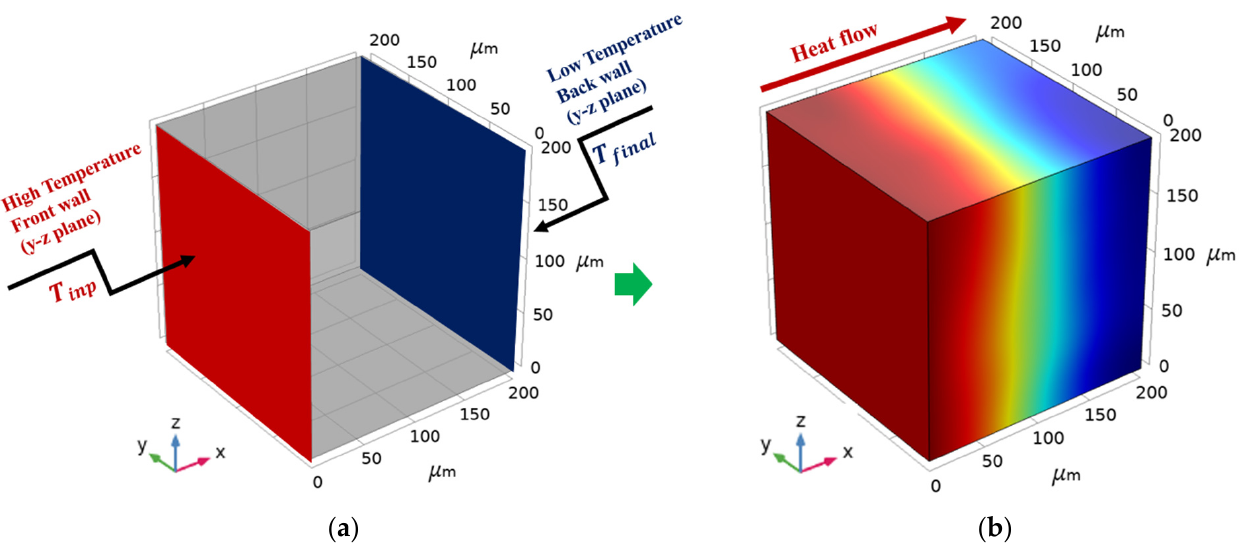
Figure 4. The 3D simulation model: ( a ) Boundary conditions; ( b ) Heat flow.